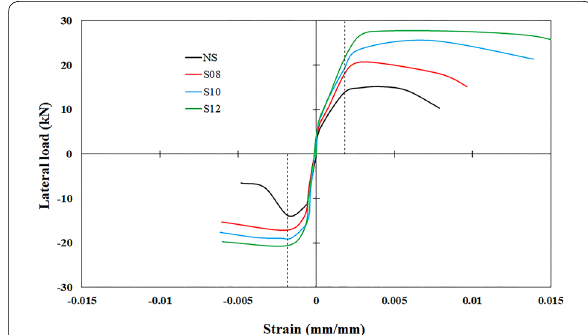
Fig. 7 Envelope curves for lateral load–strain on the strain gauge SL1 of longitudinal steel reinforcement.